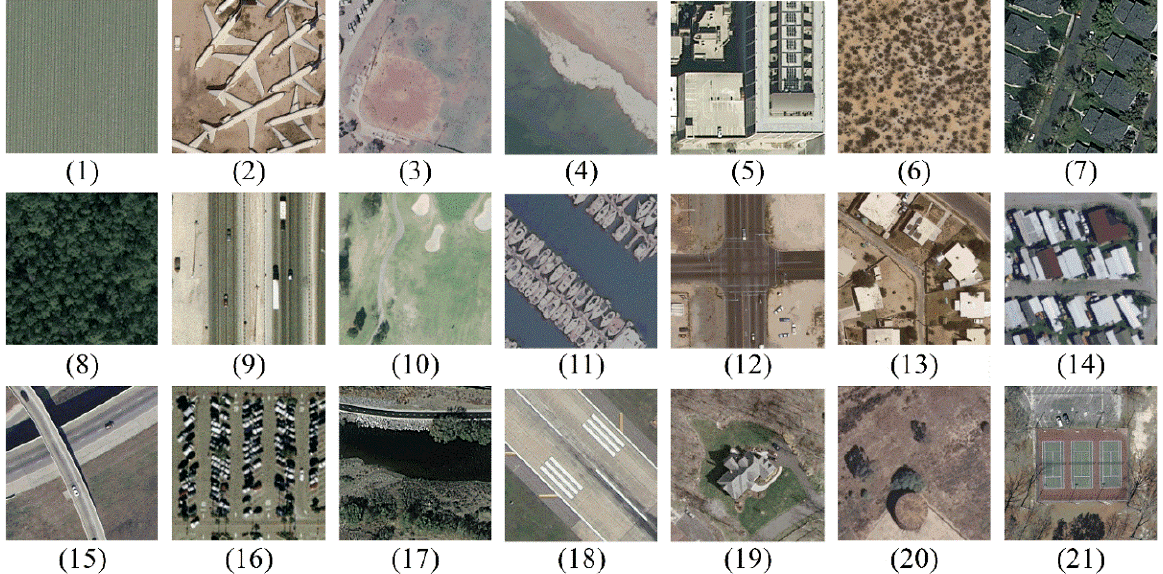
Figure 5. Example images of UC Merced Land ‐ Use dataset.